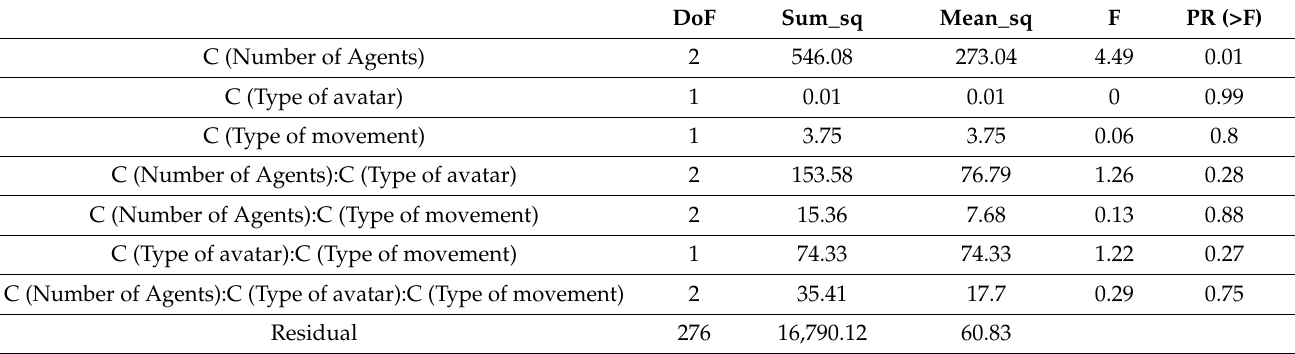
Table 2. Three-way ANOVA for vertical interference movement.